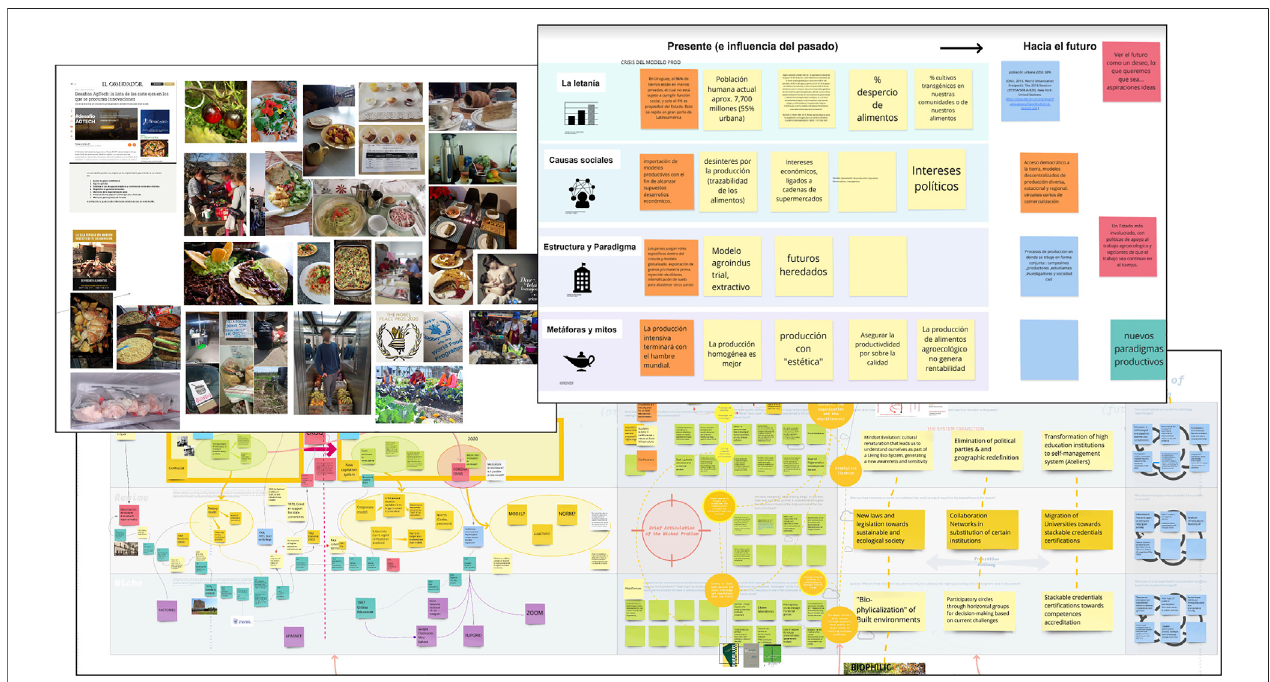
FIGURE 1 | Example of boards crafted by participants, where they collaborated and made sense of the Transition Design tools and framework using Miro, the online visual collaboration